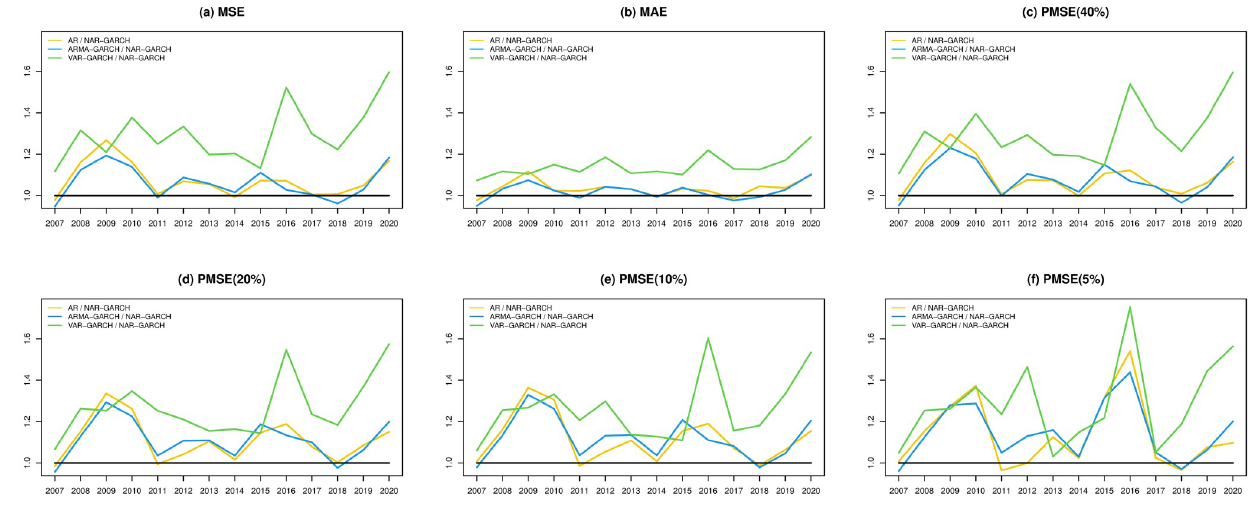
Fig 5. The prediction performances of the 4 models for the S&P 500 index.